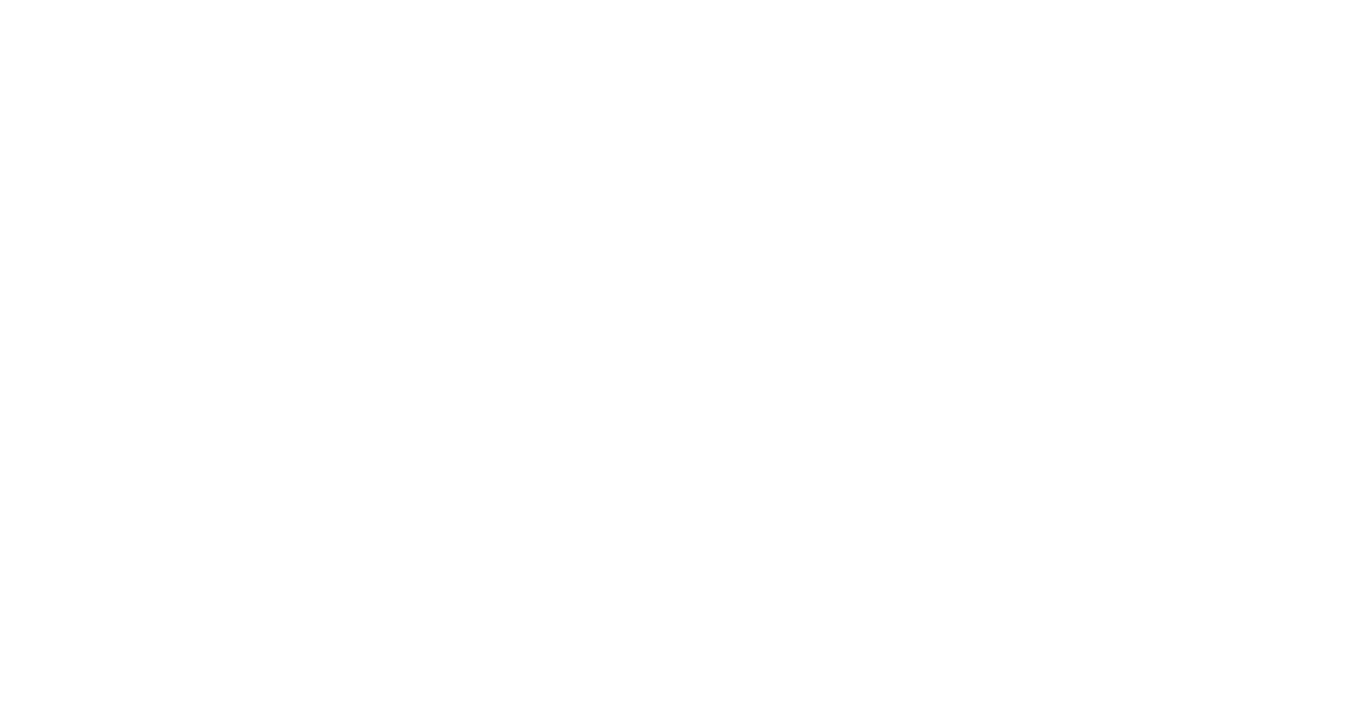
Mapping the Online Characteristics of